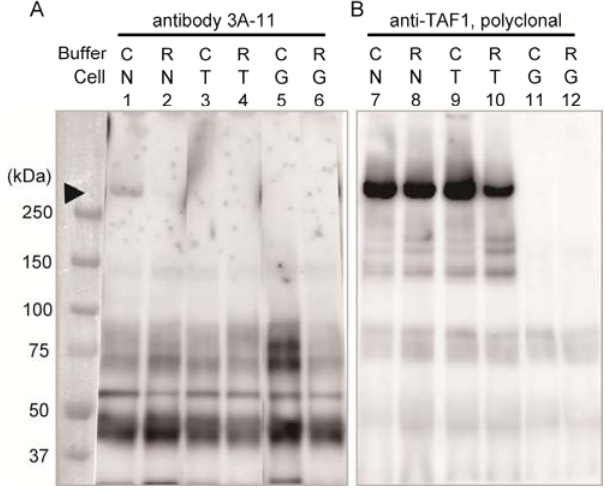
Figure 2. Immunoprecipitation using neuron-specific TATA-binding protein-associated factor 1 (N-TAF1) monoclonal antibody, 3A-11F ( A ), and TAF1 polyclonal antibody ( B ). HEK293 cells were transiently transfected with green fluorescent protein (GFP)-tagged mouse N-TAF1 (N), mouse TAF1-GFP (T) and GFP only (G) as indicated. The detection antibody was a GFP specific antibody. C indicates that cells were solubilized in Co-IP buffer and R indicates that cells were solubilized in RIPA buffer. Exposure time is seven ( A ) or one ( B )